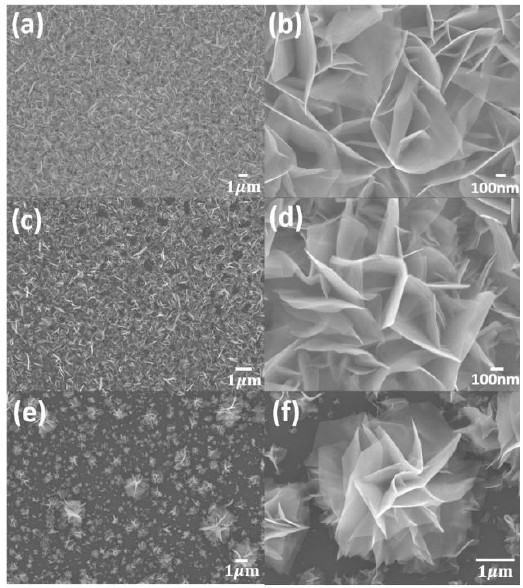
Figure 2. SEM images of vertically-oriented WS 2 nanosheets grown on a Si substrate at ( a , b ) 450, ( c , d ) 500, and ( e , f ) 550 °C.